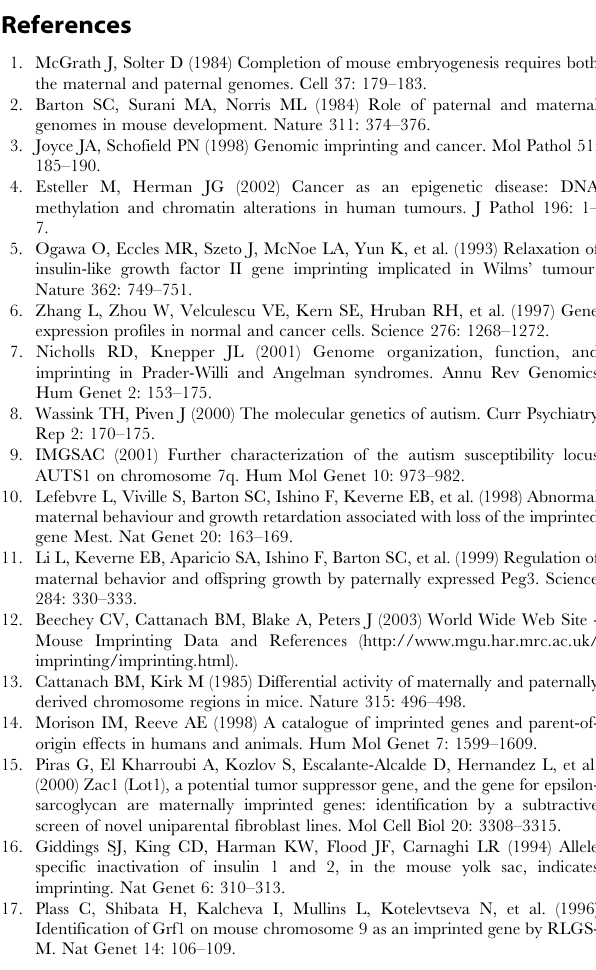
Table S1 Sequences of Oligonucleotide Primers Used in this Study.